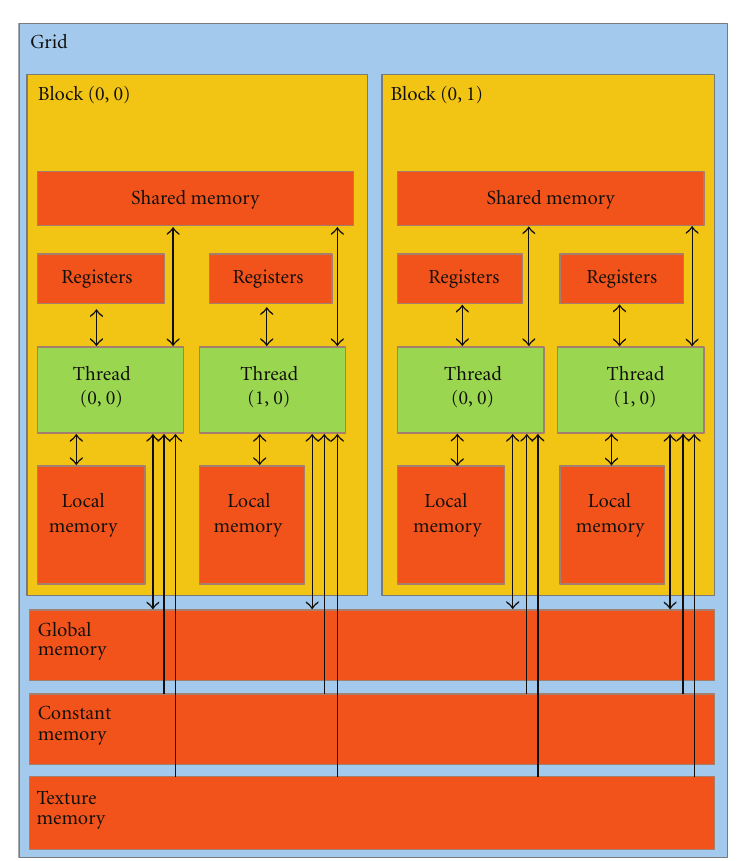
Figure 2: CUDA GPU memory model design